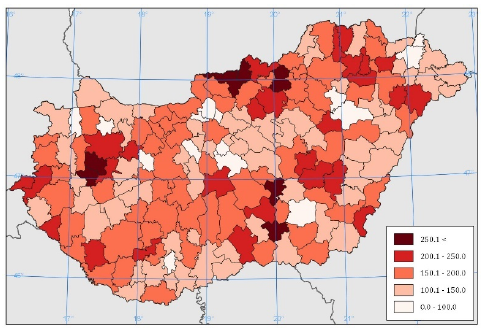
Data source : K-Monitor Figure 8: Total number of deaths caused by COVID-19 per 100,000 inhabitants at the micro-regional level of Hungary (LAU 1) between 4 March 2020 and 4 March 2021